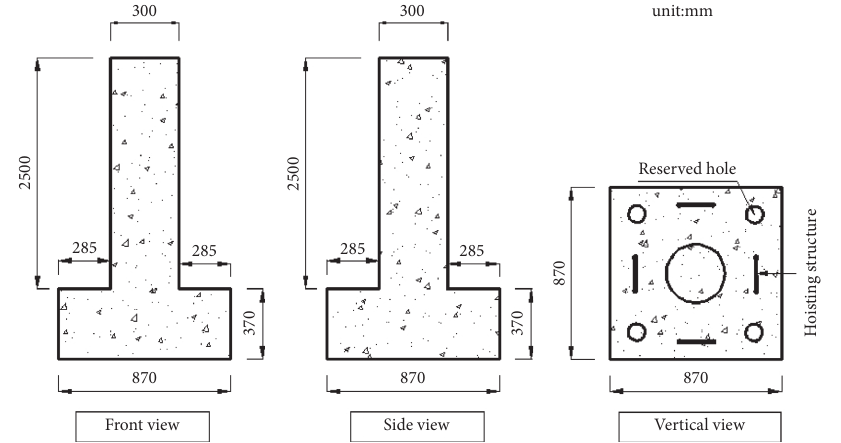
Figure 4: Schematic diagram of the model column. Table 1: Experimental materials of the model column.